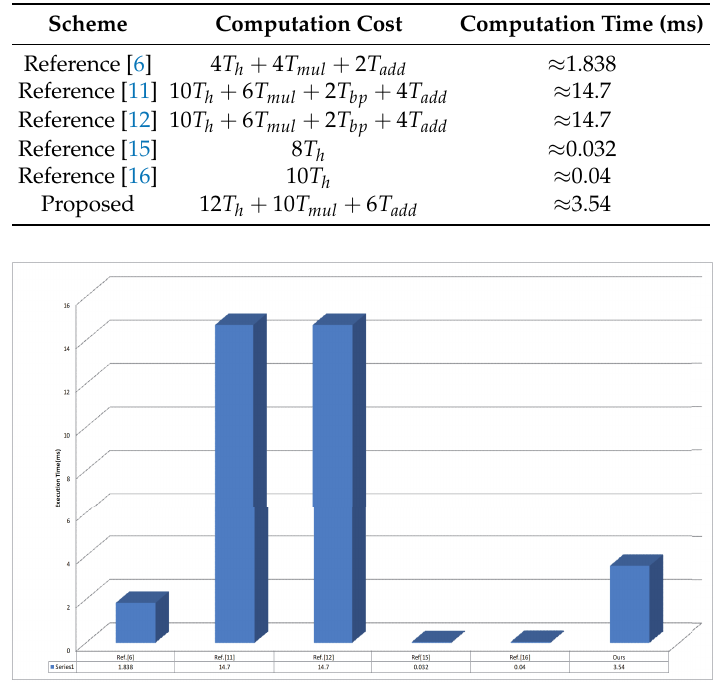
Figure 6. Execution time(ms) of different authentication